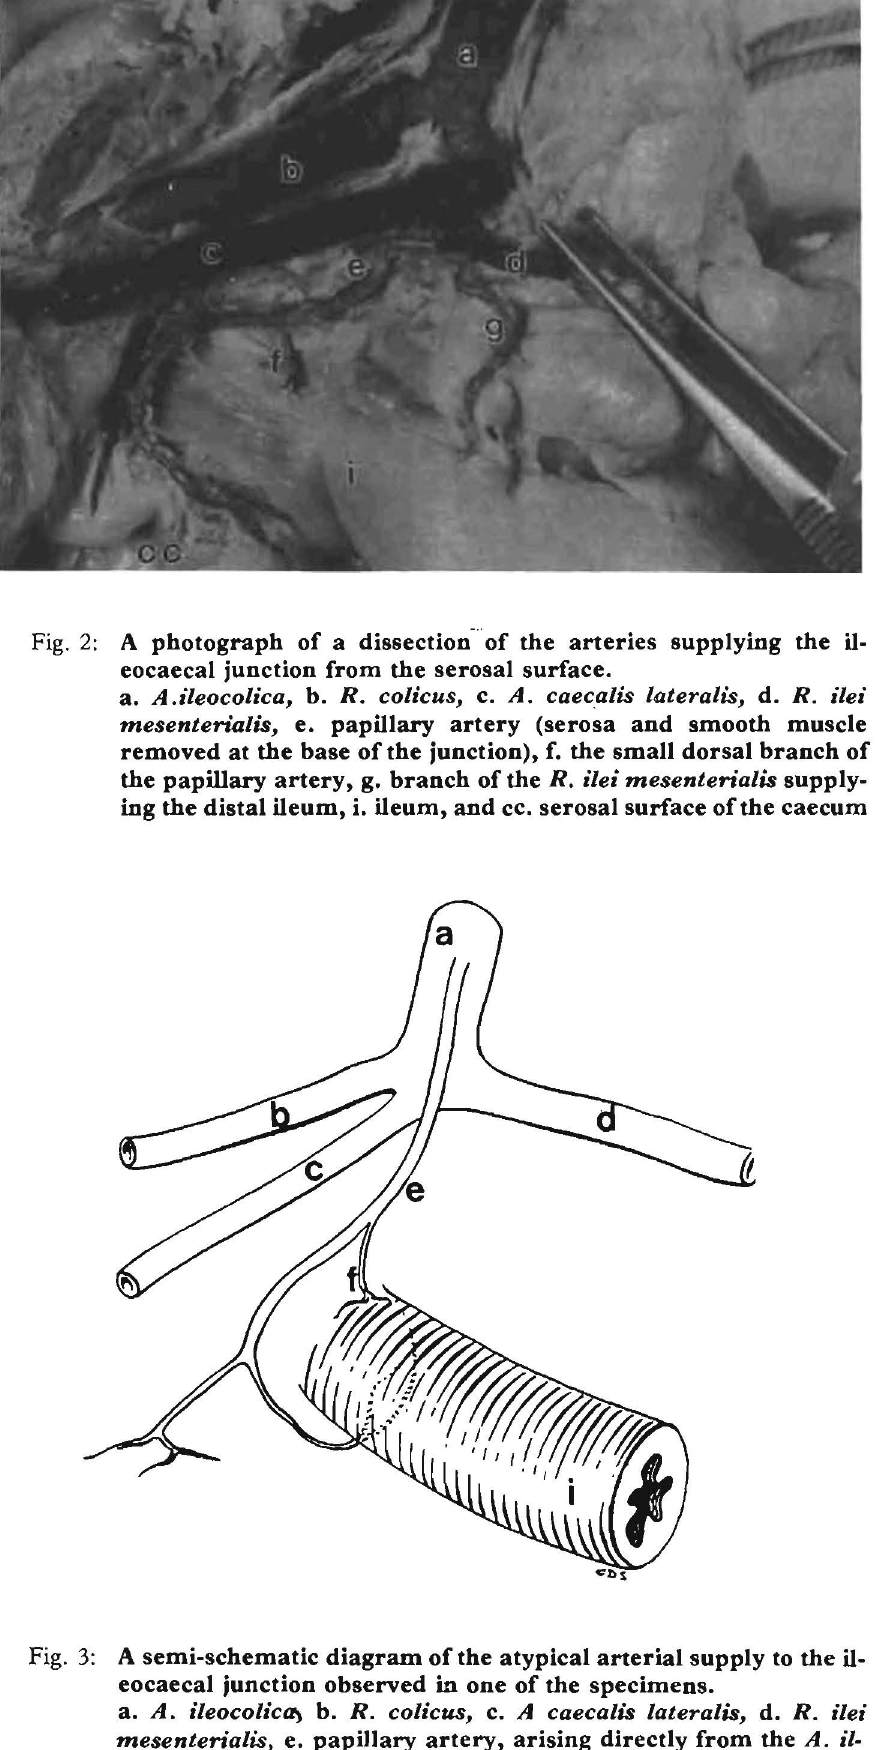
Fig. 3: A semi-schematic diagram of the atypical arterial supply to the il eocaecal junction observed in one of the